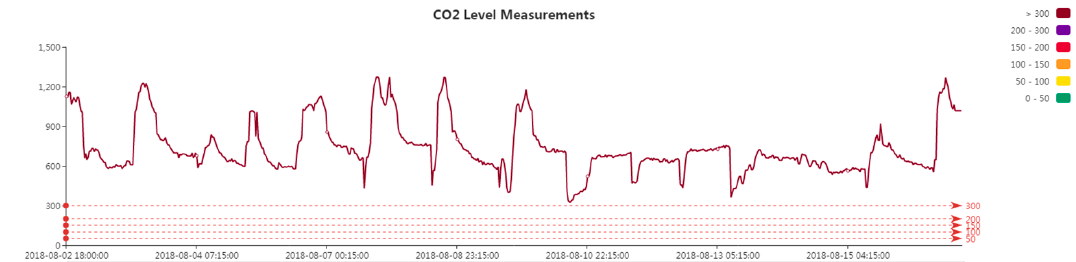
Figure 12. Indoor CO 2 Concentration.